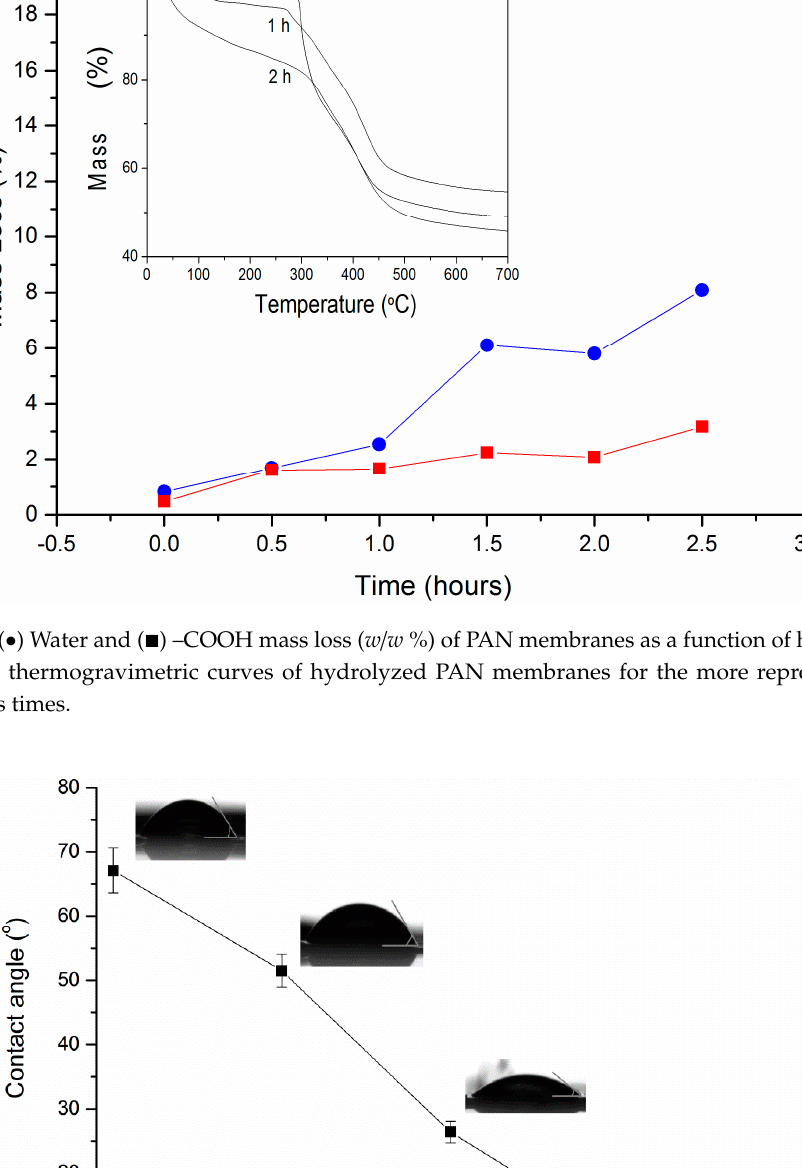
Figure 6. Contact angle of PAN membranes for different hydrolysis reaction times.